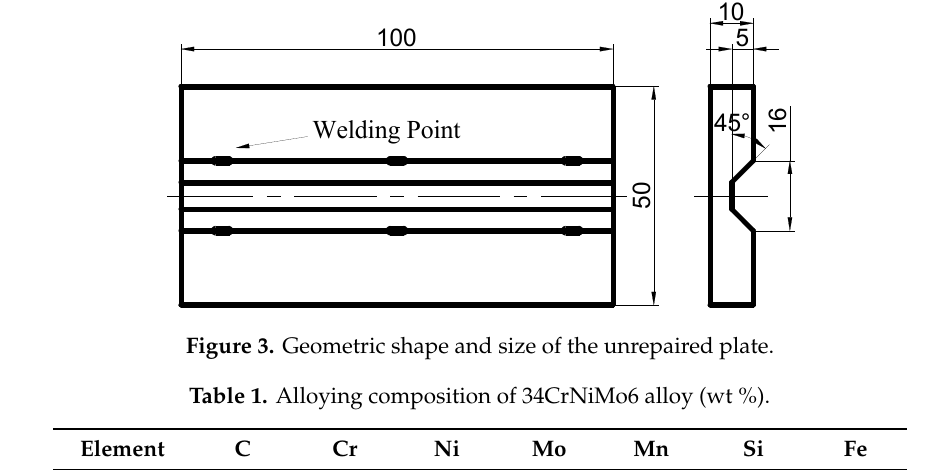
Figure 2. Schematic image of friction stir processing (FSP) repair: ( a ) schematic image, ( b ) actual process. RS, retreating side, AS, advancing side, SZ, stirred zone.